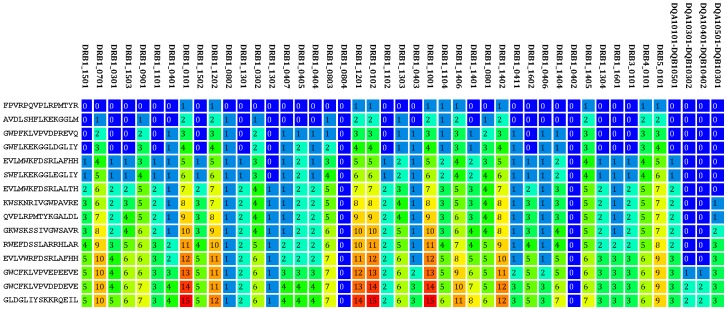
Selection of Nef-specific epitopes using the PopCover algorithm.Fifteen Tat 15-mer peptides were selected from the pool of 20,962 predicted HLA class II binders. Each row in the figure represents one peptide, and each column represents an HLA class II molecule. The value in each cell gives the cumulative number of times a given allele was predicted to bind any of the selected peptides. The first selected peptide covered only 11 over the 45 HLA alleles, however, when combined with the other peptides in the pool, the HLA coverage increased to 96% (43 out of 45). When taking the allelic frequency into account, this corresponded to a population-coverage of 99.8%. The coverage of the HIV genomes was similar. The first selected peptide (FPVRPQVPLRPMTYR) is present in 253 of the 396 genomes (64%) included in the analysis. With the other peptides in the pool, this coverage is increased to 99.0%.